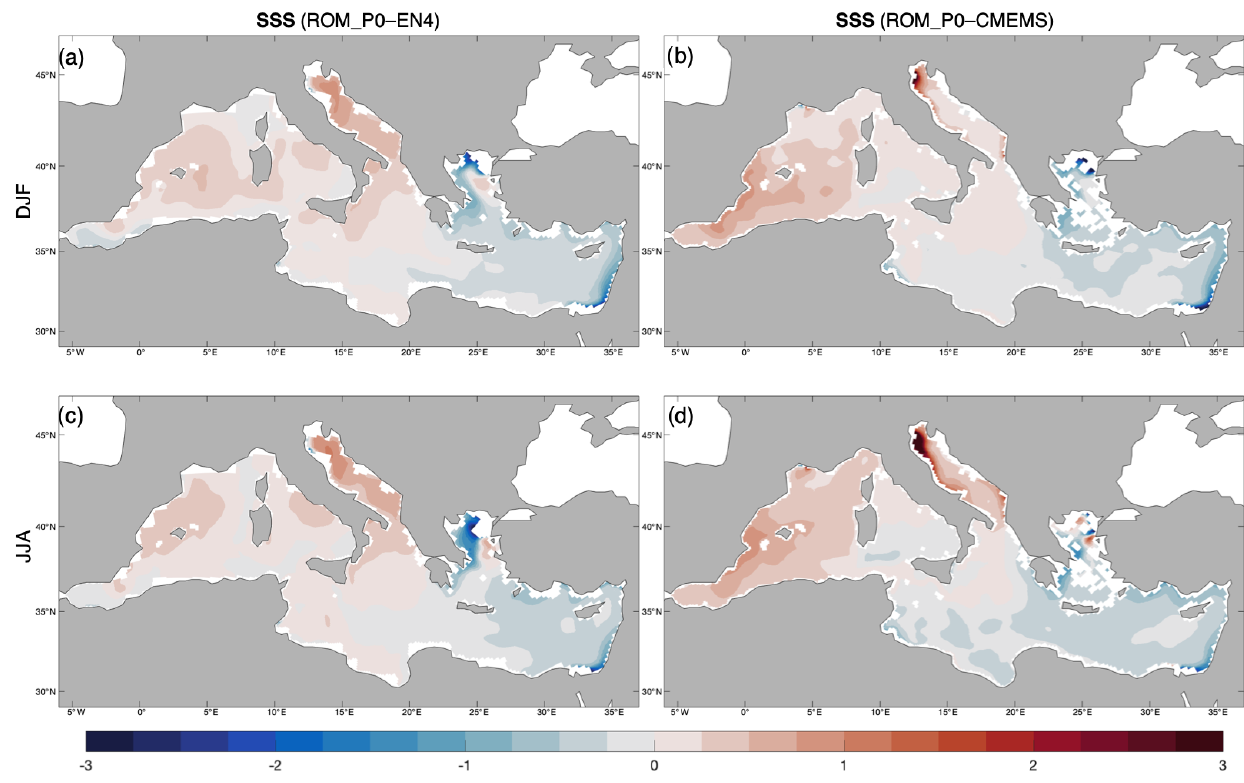
Figure 9. SSS (psu) differences between the ROM_P0 climatologies (EN4 a, c and CMEMS d, e ) in winter (DJF a, b ) and summer (JJA c, d